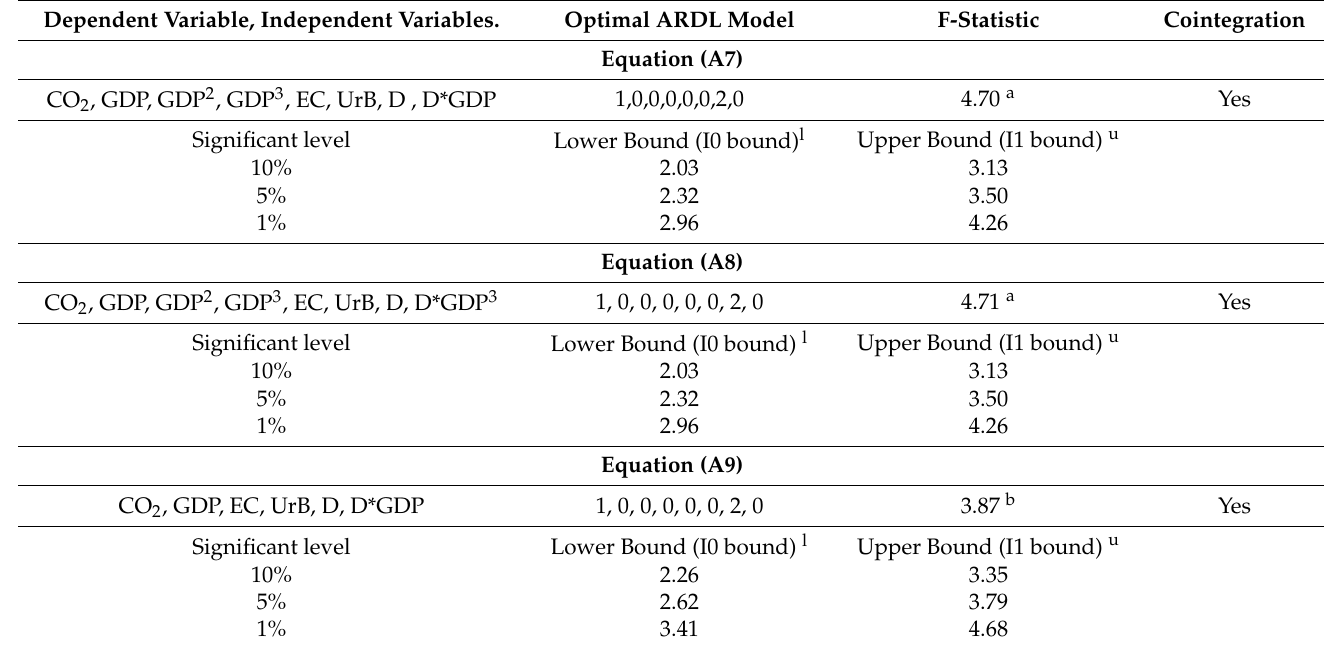
Table A7. ARDL bounds test for